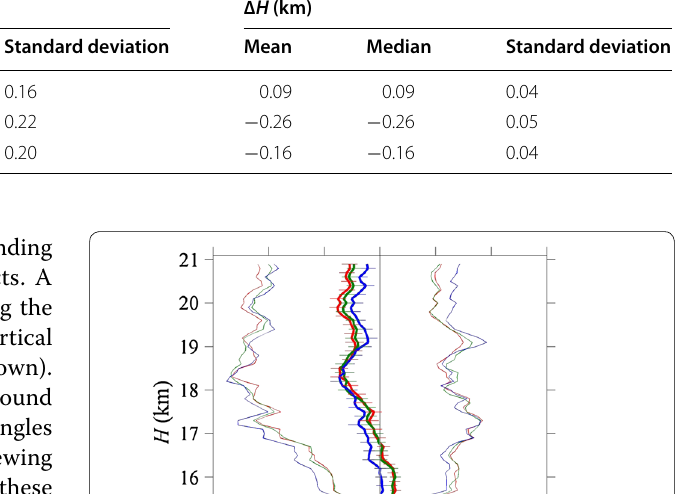
Table 3 Statistical differences of LRT among the three GPS-RO datasets ∆ T (K)